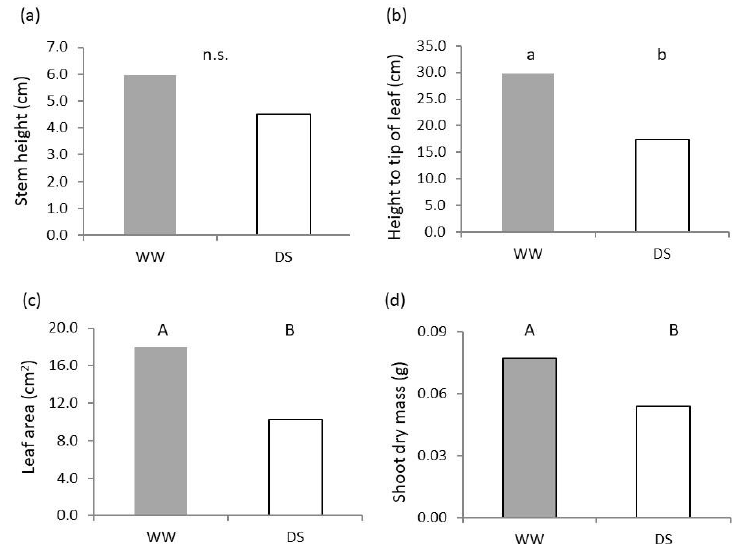
Figure 1. Effect of soil water availability on seedling shoot: ( a ) Height to the uppermost node; ( b ) height to the tip of the uppermost expanded leaf; ( c ) leaf area; and ( d ) shoot dry mass. Different letters on each bar designate significantly different values at the Tukey’s post hoc mean separation test for p < 0.05 (lowercase letters), p < 0.01 (uppercase letters) or non-significant differences (n.s.) for p > 0.05.